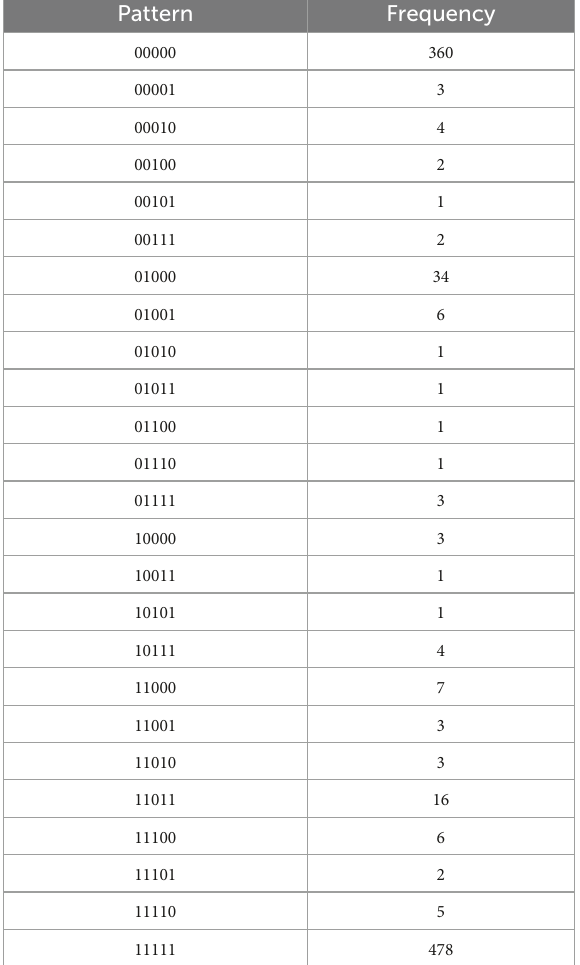
TABLE 4A Intrinsic regulation, with N = 948, k = 5 items, and u = 25 unique response patterns ( Appendix B ). Pattern